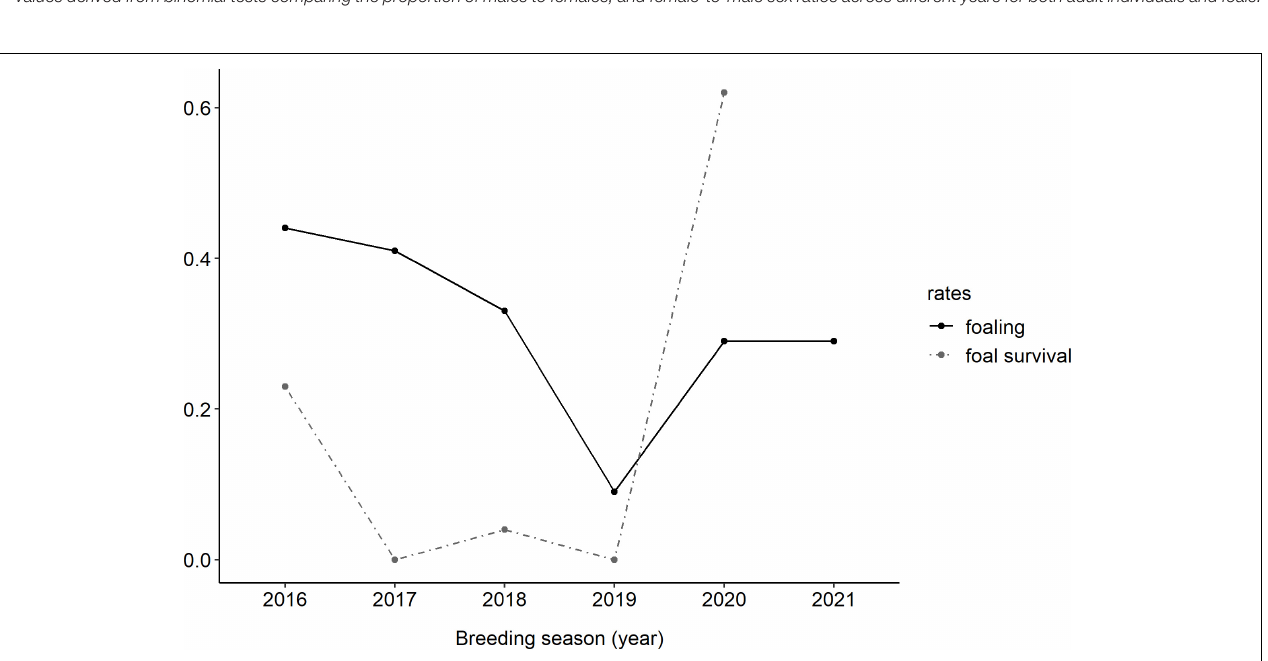
FIGURE 2 | Foaling rate and foal survival over the study period. Foaling rate was calculated as the number of foals born divided by the number of females of reproductive age. Survival rate was calculated as the number of foals that survived the first year within a year divided by the number of foals born in each breeding season.